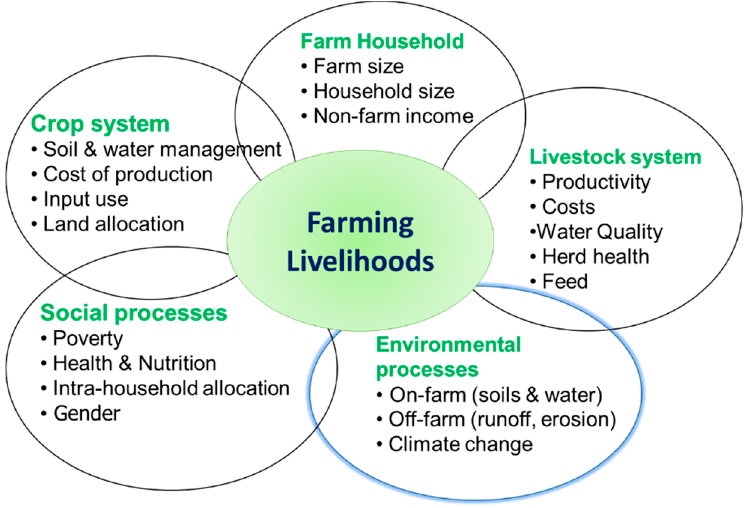
Figure 1. The agricultural production system and farming livelihood. Source: [20].